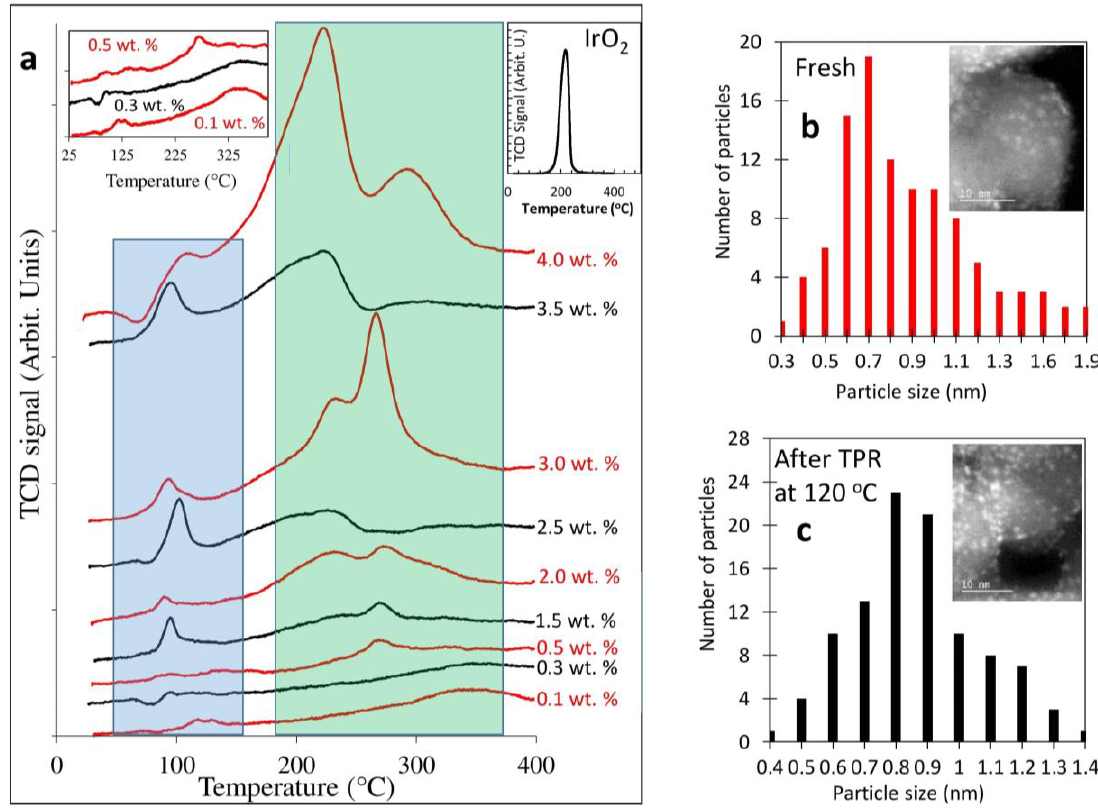
Figure 5. ( a ) TPR profiles of IrO 2 /TiO 2 catalysts with the indicated Ir wt.%: 0.1 wt.% (59.5 mg); 0.3 wt.% (58.4 mg); 0.5 wt.% (59.4 mg); 1.5 wt.% (61.3 mg); 2.0 wt.% (62.2 mg); 2.5 wt.% (61.7 mg); 3.0 wt.% (63.3 mg); 3.5 wt.% (63.1 mg); 4.0 wt.% (100 mg). The top inset in ( a ) is a magnification of the signal in region 1 for the 0.1–0.5 wt.% IrO 2 catalysts, while the top right inset is the TPR of polycrystalline IrO 2 . ( b ) Particle size distribution obtained from STEM images of 1 wt.% IrO 2 /TiO 2 catalyst before ( b ) and after ( c ) TPR up to 120 °C. The mean particle size increased from 0.6 – 0.7 nm to 0.8 – 0.9 nm. The insets in ( b , c ) are representative STEM images where some sintering can be observed (reduction without sintering would result in a decrease in the particle size by about half (see text for further explanation)). The first highlighted region is largely attributed to amorphous phases, while the second one is attributed to crystalline phases of IrO 2 (see text for more interpretations).